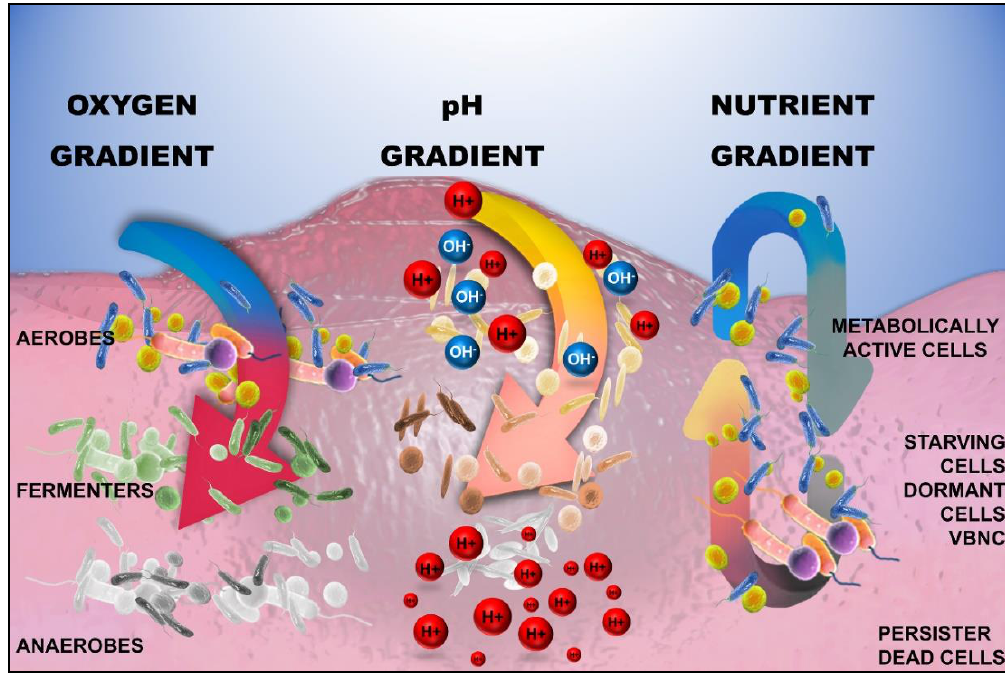
Figure 3. Heterogeneity in the structure of the biofilm due to the presence of oxygen, pH, and nutrient gradients. The utilization of nutrients and oxygen occurs at a rapid rate, resulting in early depletion near the surface, subsequently altering the biochemical milieu with a reduction in pH closer to the attachment surface: H+—Hydrogen ion, OH − —hydroxyl ion; VBNC—viable but not culturable cells.